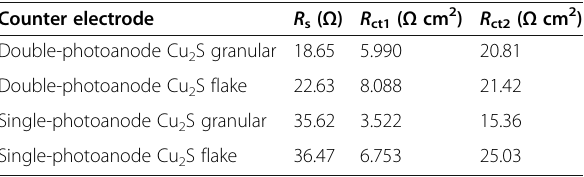
Table 2 Fitted values of R S , R ct1 , and R ct2 of QDSSCs with different structures and morphologies from the Nyquist plots Counter